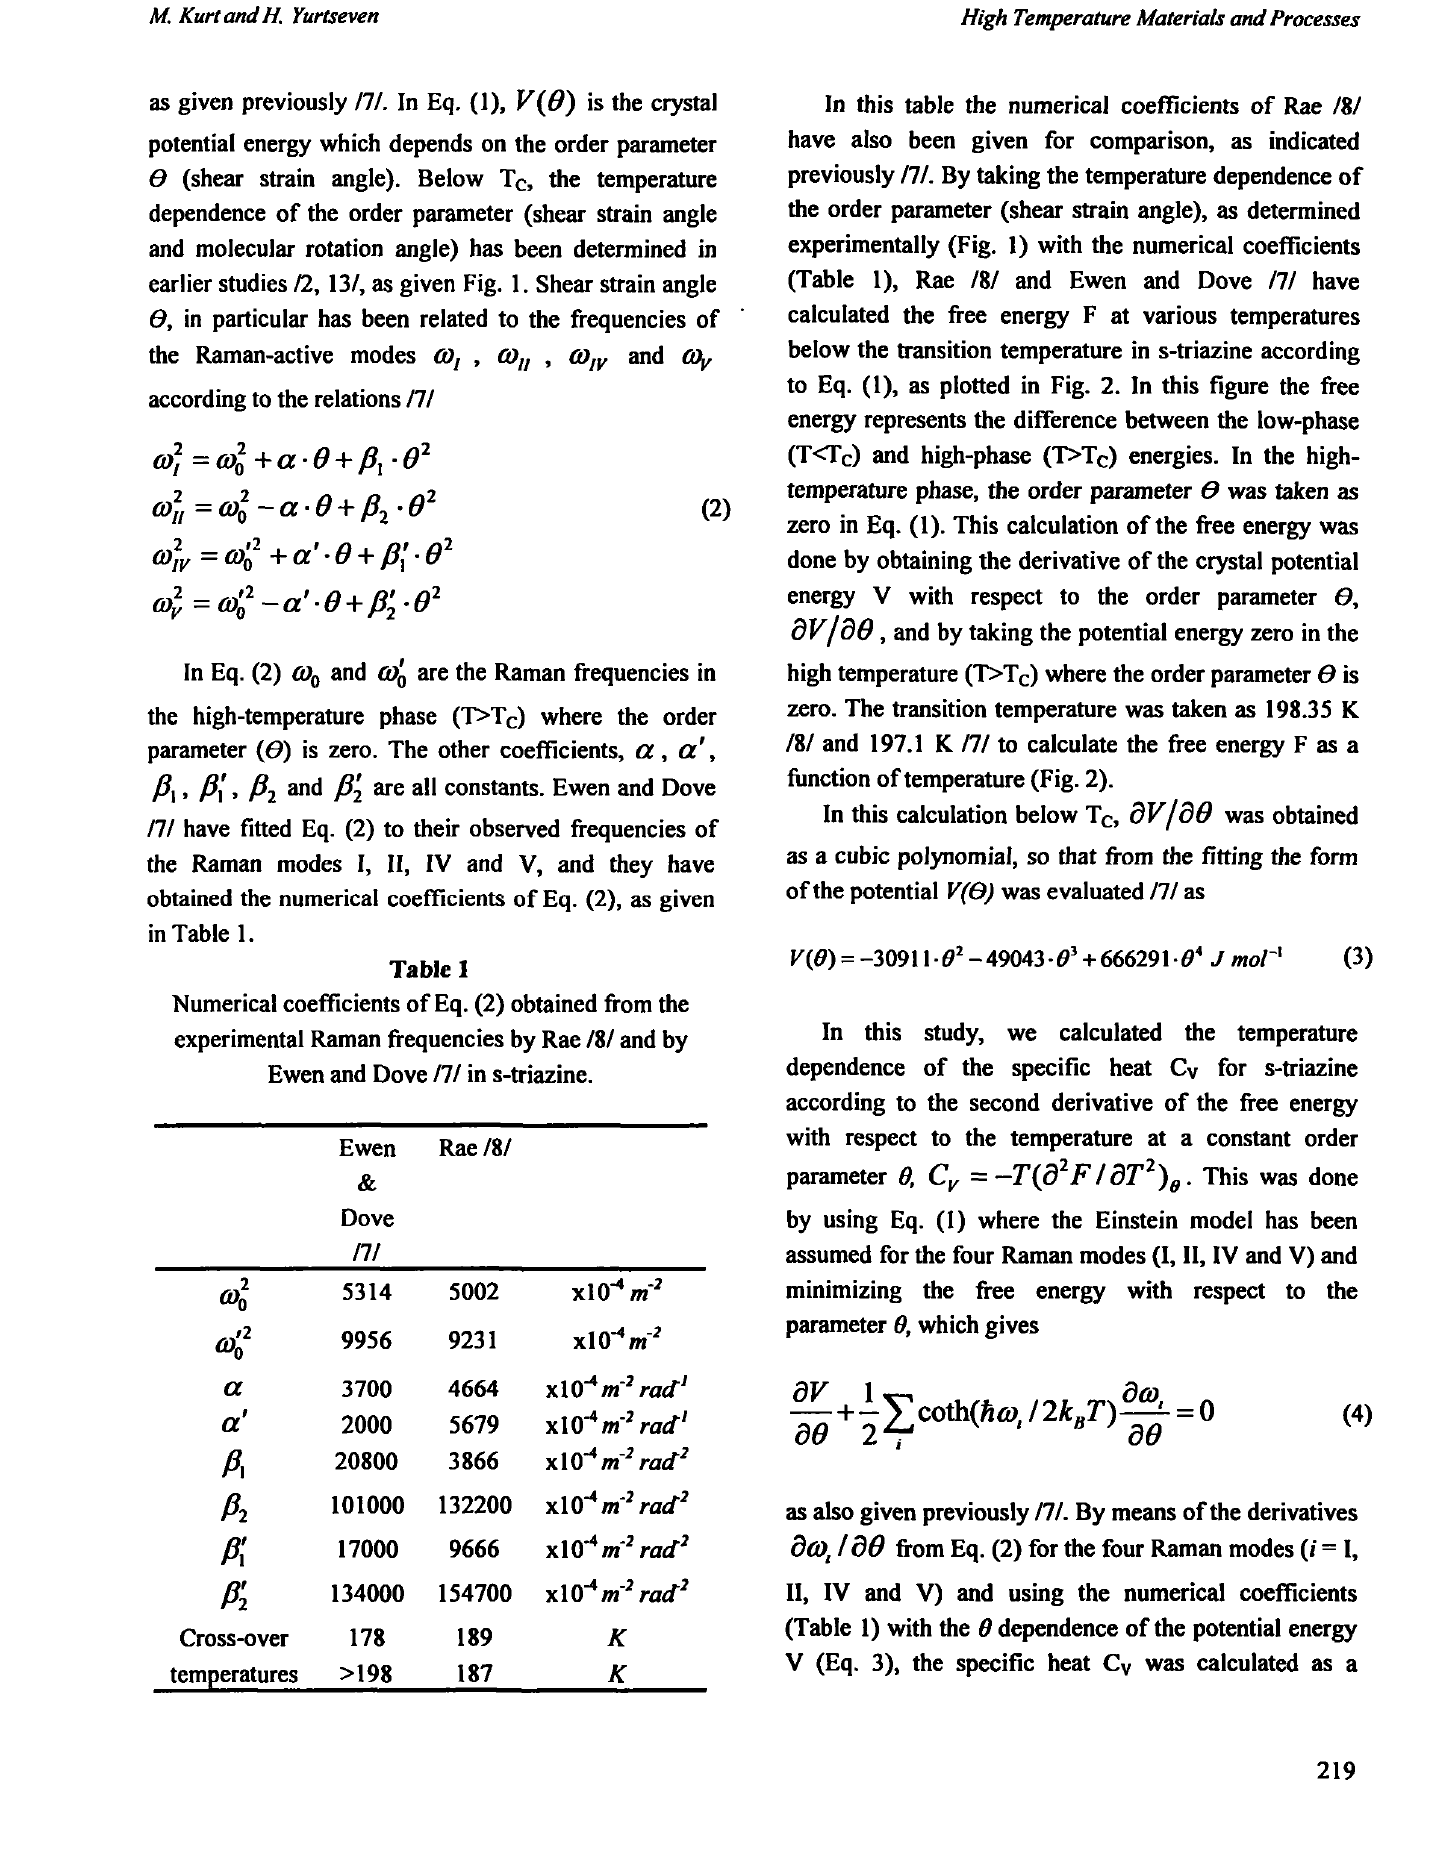
Numerical coefficients of Eq. (2) obtained from the experimental Raman frequencies by Rae /8/ and by Ewen and Dove ΠI in